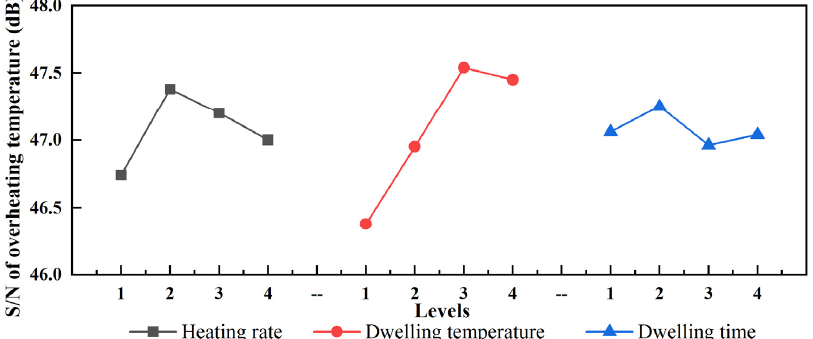
Figure 13. Mean SNR values under four levels of three factors.